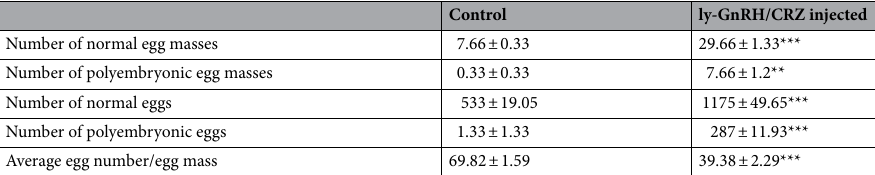
Table 1. Egg laying behavior of experimental groups. Values represent mean ± SEM (n = 10 animals/group/ replicates); significant results, in comparison with the control, are indicated by asterisks (** P < 0.01 and *** P < 0.001).